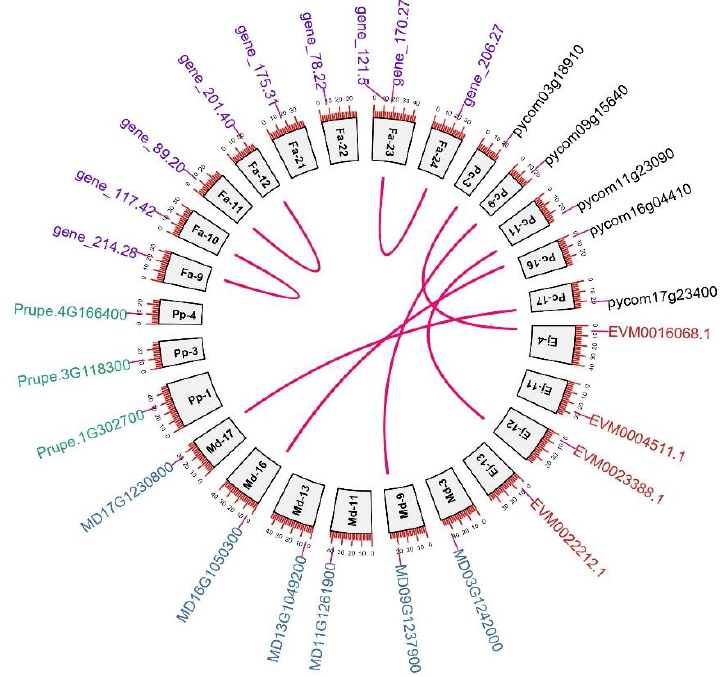
Figure 5. Chromosomal distribution and gene duplication of the PEPC genes in five Rosaceae species. Gene IDs of loquat, apple, peach, strawberry, and pear are labeled in red, blue, green, purple, and black colors, respectively. Red lines represent the putative WGD/segmental-duplication of genes. Table 4. The K a (nonsynonymous), K s (synonymous), and K a /K s ratio of duplicated PEPC genes in five Rosaceae